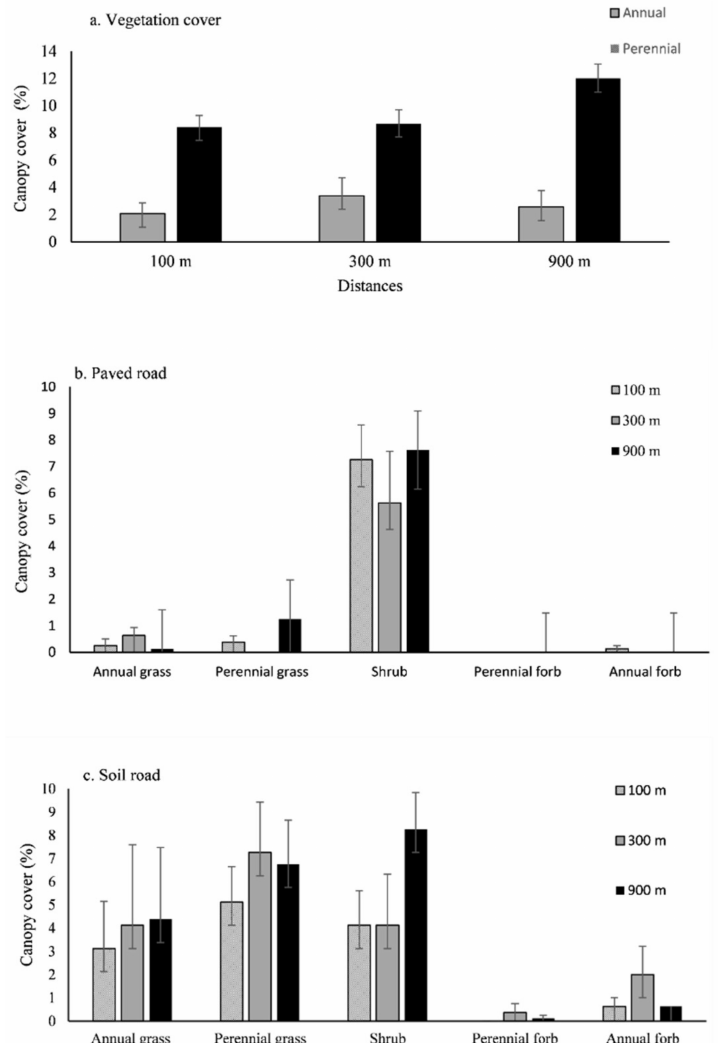
Figure 6. ( a ) Total canopy cover at the three distances from the paved and soil roads. ( b ) Canopy cover of plant functional groups at the three distances from the paved roads. ( c ) Canopy cover of functional groups at the three distances from the soil roads. Each bar represents mean ± 1 SE.